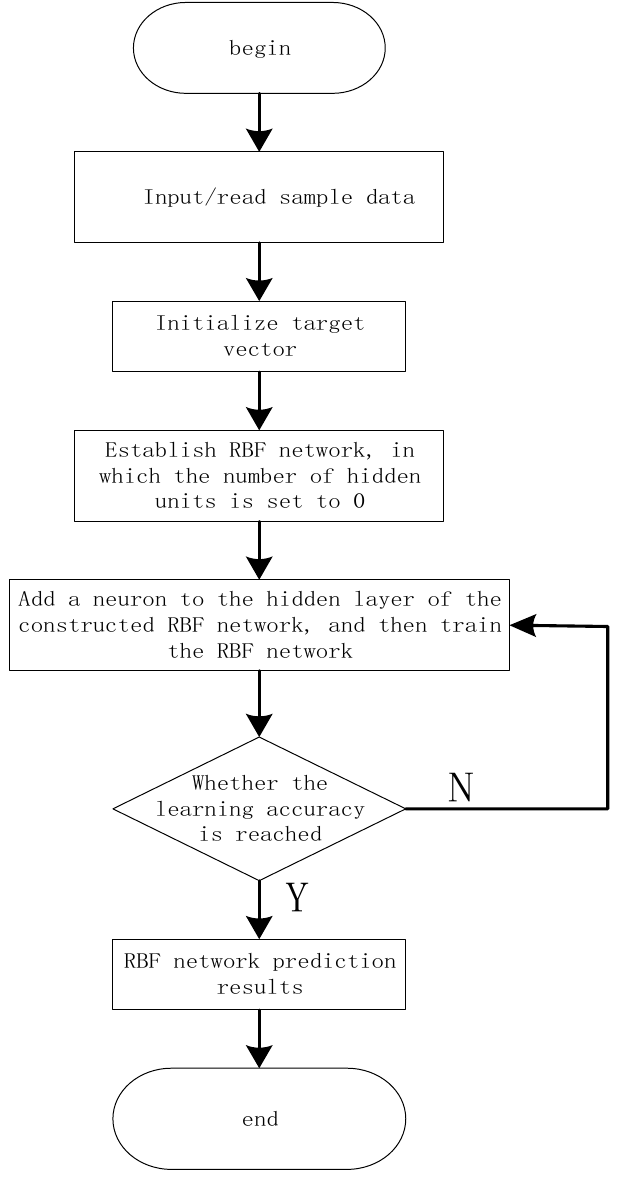
Figure 16. Flowchart of RBF neural network prediction. When using the RBF network to approximate the function, The network output at this time is: An = sim ( net , p n ) The output value needs to be denormalized to obtain the predicted actual value. Figure 17 shows the prediction confidence interval graph. Where the x-axis is the time and the y-axis is the delay. The red line is the 95% confidence interval. For comparison, Figure 18 shows the prediction and actual latency of the RBF neural network. where the x-axis is the running time and the y-axis is the corresponding time delay. Figure 19 shows the errors between the actual and predicted values. where the x-axis is the running time and the y-axis is the corresponding time delay. When the network latency is relatively stable, using the RBF neural network to predict the latency can achieve a higher prediction accuracy. More than 95% of the prediction values have an error within